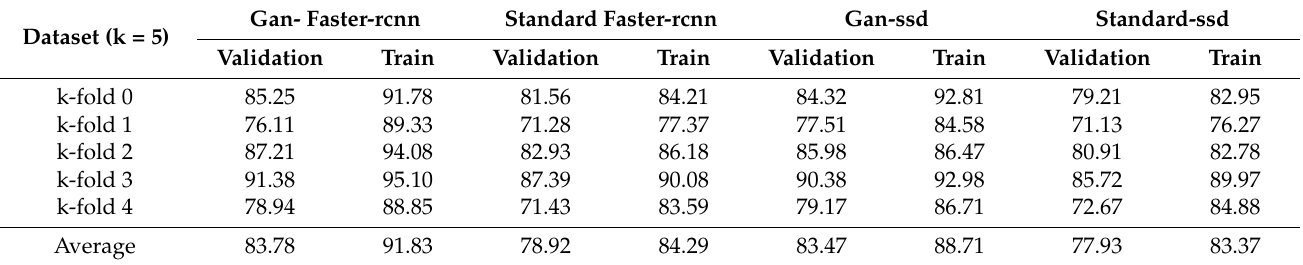
Table 4. K-fold cross validation classification accuracy (%) of the four model methods.